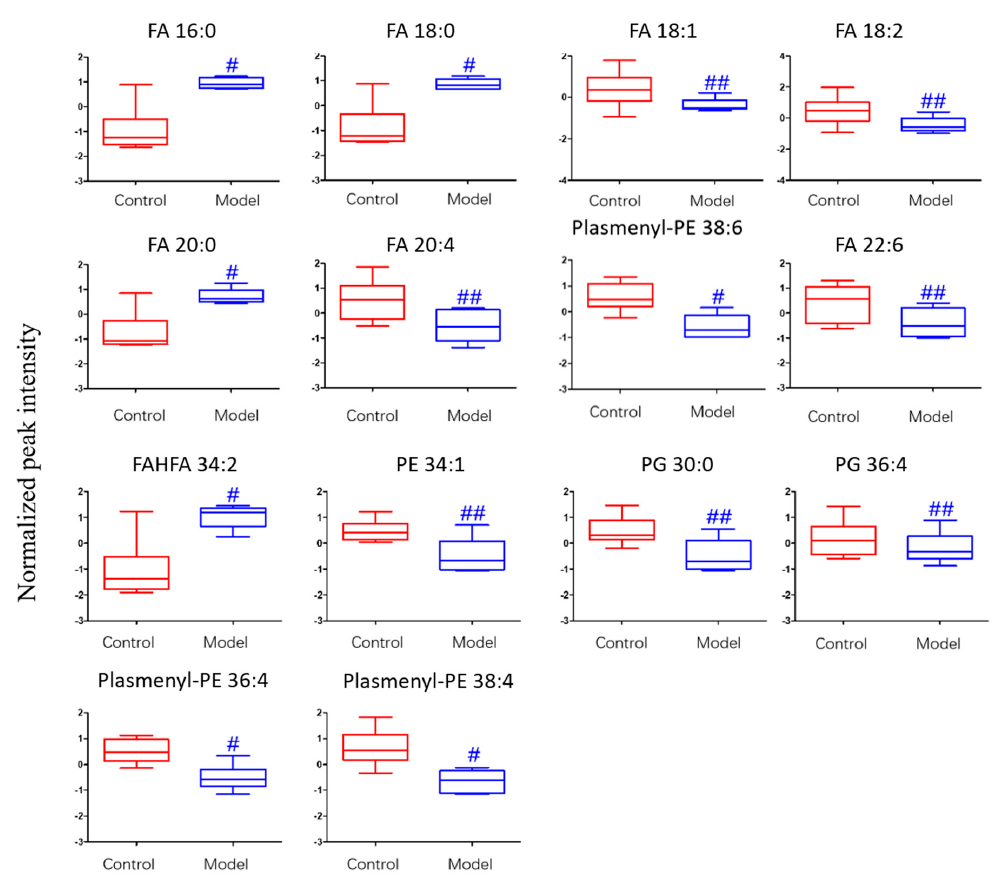
Figure 6. Heatmap of identified differential lipids in BALF (positive ion mode). Each square in the heatmap represents the corresponding intensity value of a phospholipid of samples in each group, red represents the increase in concentration and blue represents the decrease in concentration.